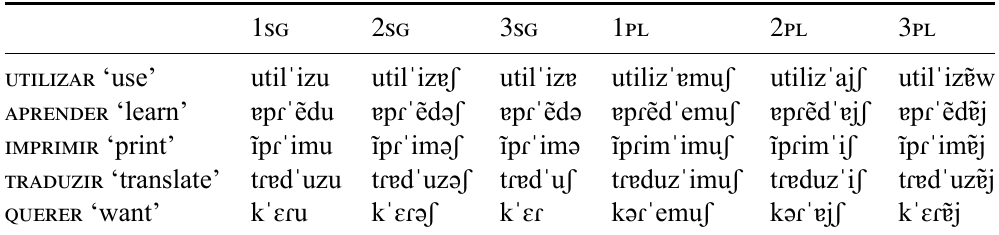
Table 16: The indicative present paradigm, showing interpredictability between the 2SG and the